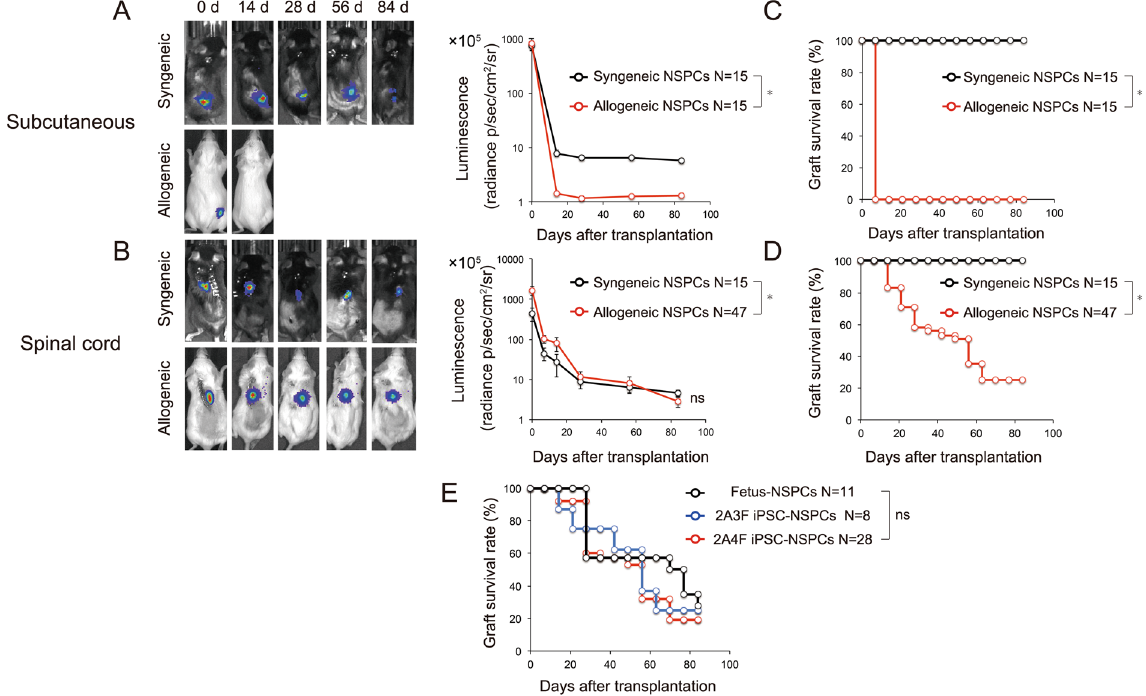
Figure 4. Bioluminescence and graft survival rate after transplantation of fetus-NSPCs and iPSC-NSPCs into syngeneic and allogeneic mice. ( A , B ) Bioluminescence images of representative mice at 0, 14, 28, 56, and 84 days after transplantation, and quantitative analyses of CPM derived from grafted fetus-NSPCs and two lines of iPSC-NSPCs (2A3F and 2A4F) in subcutaneous lesions and spinal cords (black line = syngeneic transplantation; red line = allogeneic transplantation). ( C , D , E ) Graft survival rates after transplantation into subcutaneous lesions ( C ) and spinal cords ( D and E ). The black line shows the fetus-NSPCs transplantation group, the blue line shows the 2A3F iPSC-NSPCs transplantation group, and the red line shows the 2A4F iPSC- NSPCs transplantation group. Values represent the mean ± SEM. * P < 0.05, one-way ANOVA followed by the Tukey–Kramer test. The graft survival rates were assessed using Kaplan–Meier survival curves. * P <